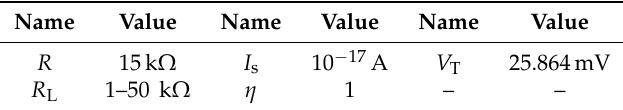
Table 2 summarizes all parameter values for the proposed Lockhart wavefolder model. Table 2. Parameter values for the Lockhart wavefolder described by Equation